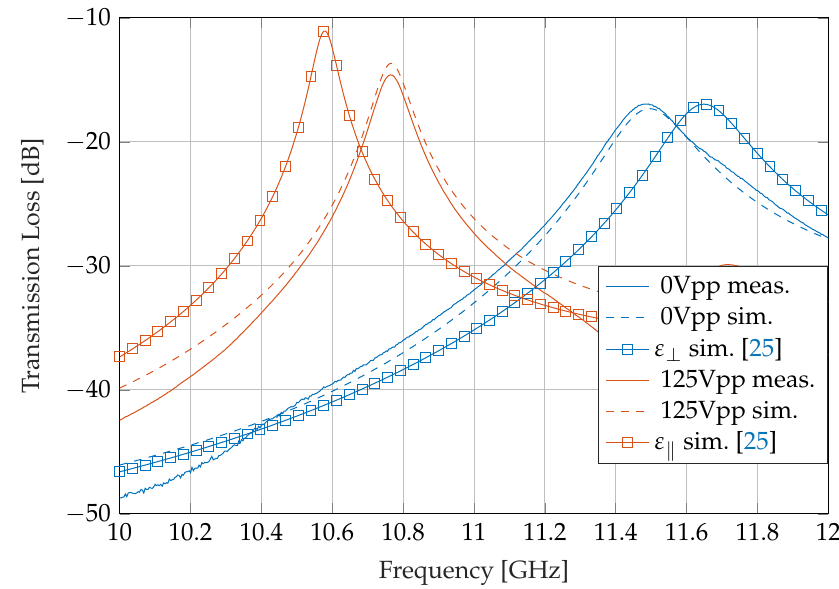
Figure 10. Frequency response of the resonator at steady state and at V max bias voltage versus the simulation with ε ⊥ and ε (cid:107) materials filling the